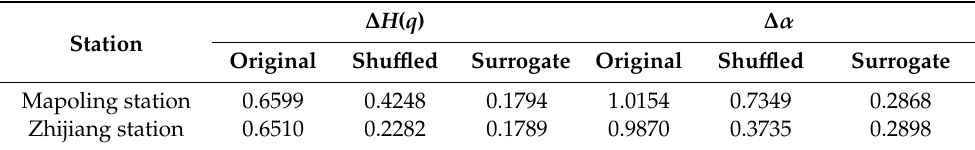
Table 3. Multifractal parameters of original, shu ffl ed, and surrogate daily precipitation time series data at the Mapoling and Zhijiang